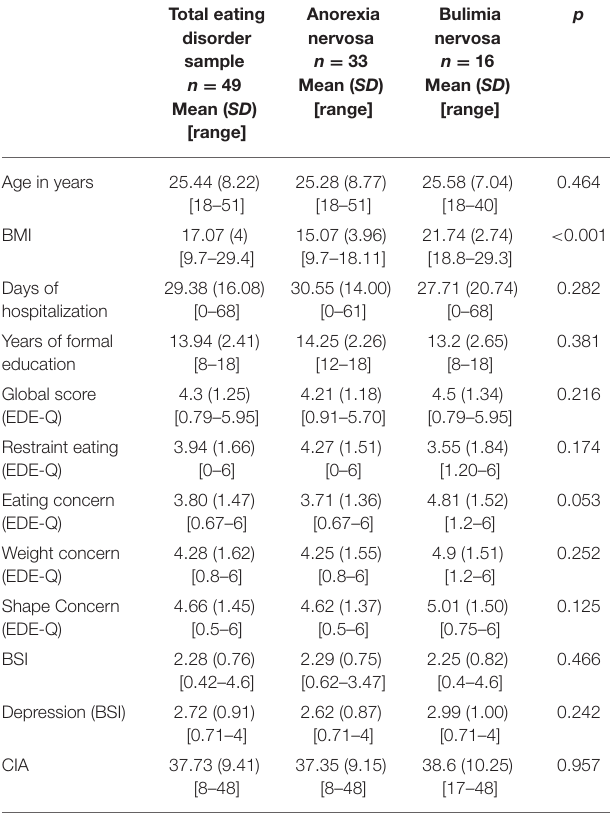
TABLE 1 | Clinical data, eating disorder, and general psychopathology by eating disorder